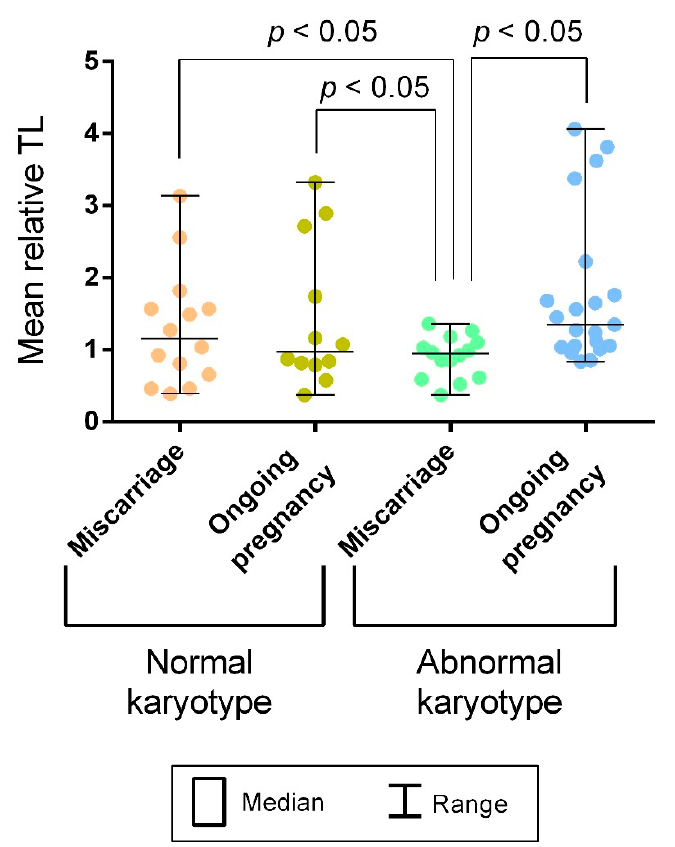
Figure 5. Interindividual variability of mean relative telomere lengths (TLs) in metaphase chromo- somes from chorionic cytotrophoblast in karyotypically normal and abnormal miscarriages and on- going pregnancies. In karyotypically abnormal chorionic cytotrophoblast the TL variance is signifi- cantly lower than in other groups under study ( p < 0.05).